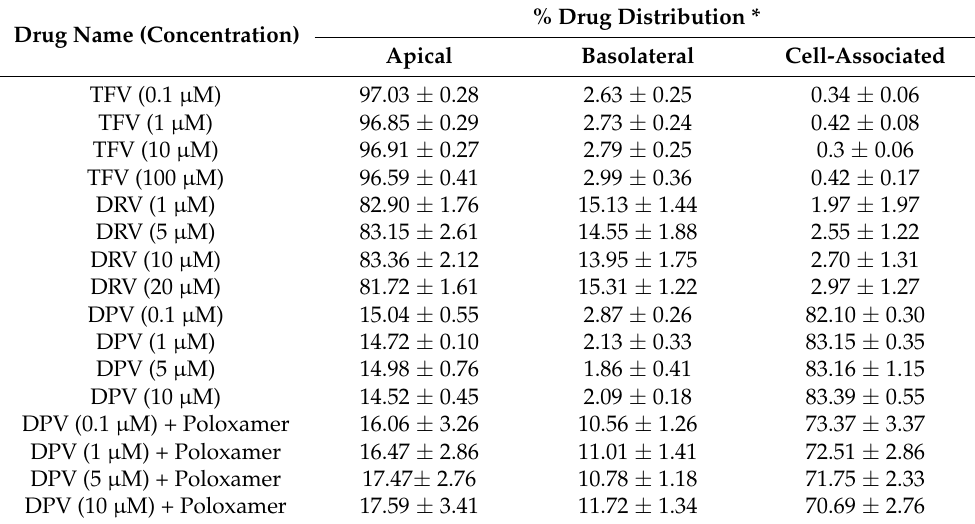
Table 2. Cell-associated drug and distribution between the apical and basolateral compartments on evaluation of absorptive